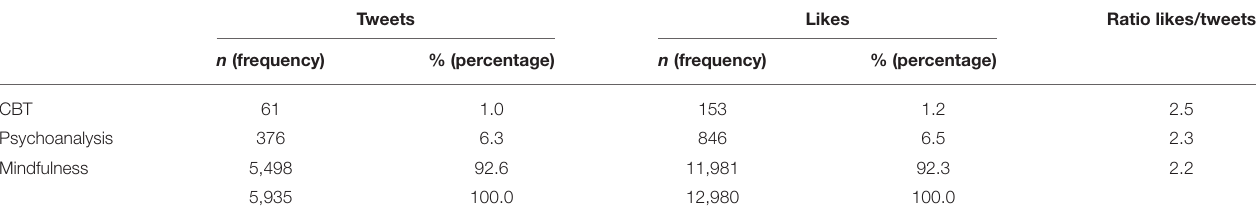
TABLE 1 | Number of tweets posted from 2009 to 2019 by 25 major US media outlets about psychotherapies and the likes generated by Twitter